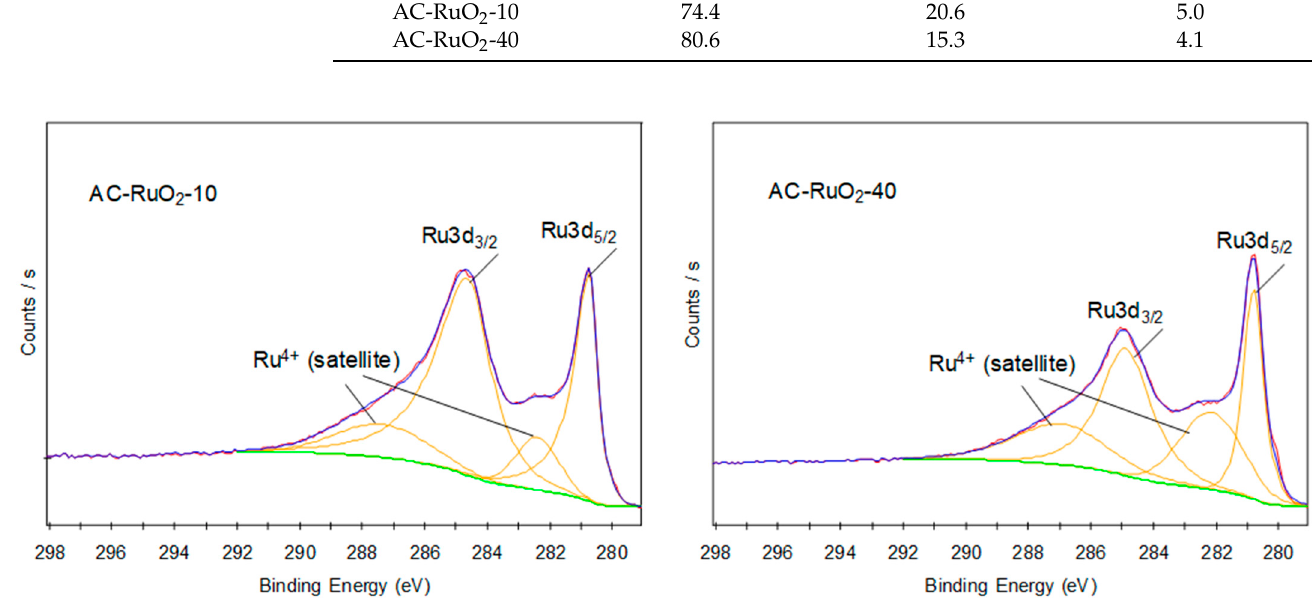
Figure 7. High-resolution C1s/Ru3d spectra of AC-RuO 2 -10, and AC-RuO 2 -40, respectively.